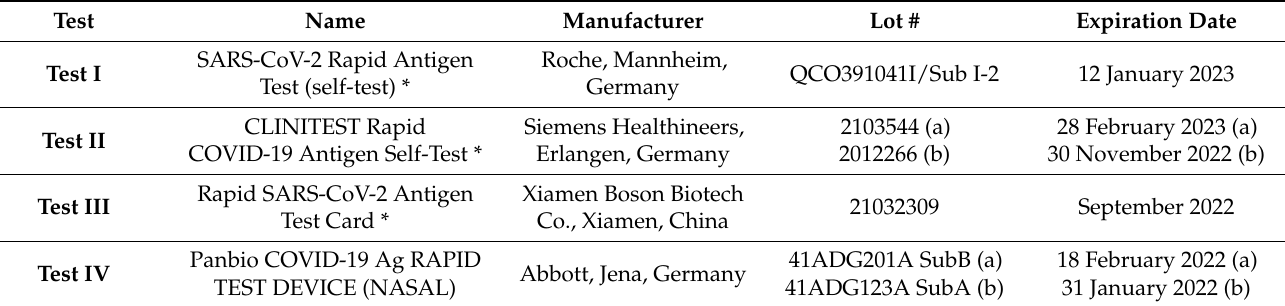
Table 1. Rapid antigen tests evaluated in this